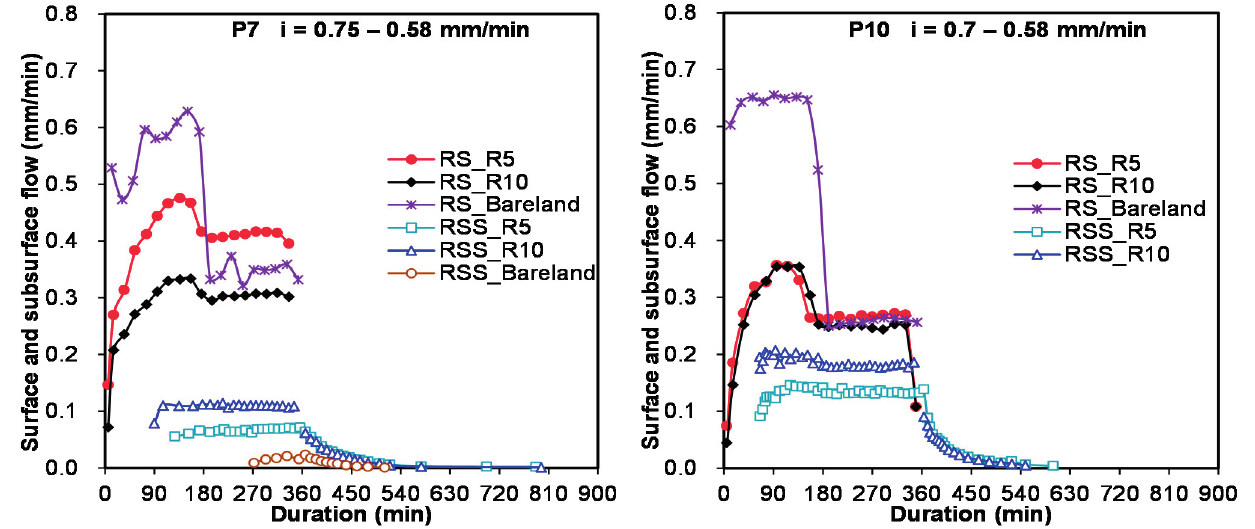
Figure 3. Rainfall-runoff process during the P7 and P10 events with variable rainfall intensity. The vertical dashed line represents the time of the end of the rainfall